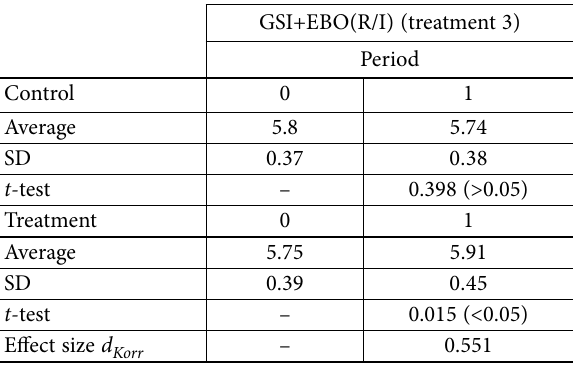
Table 5. Distance travelled in km with one gallon